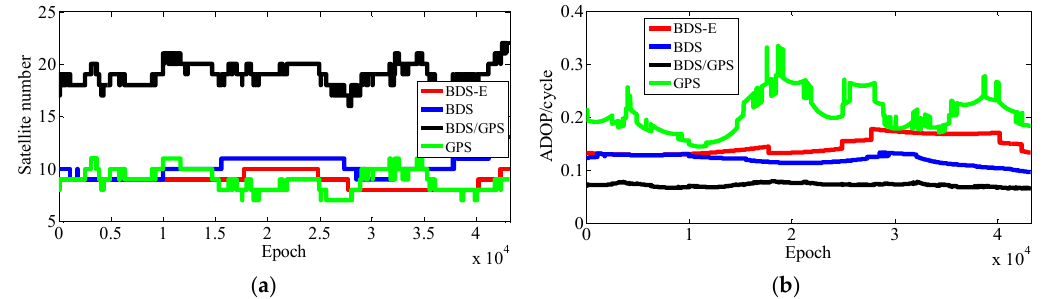
Figure 8. Satellite number and ADOP of four systems for group B. ( a ) The satellite number of four systems for group B. ( b ) The ADOP of four systems for group B.